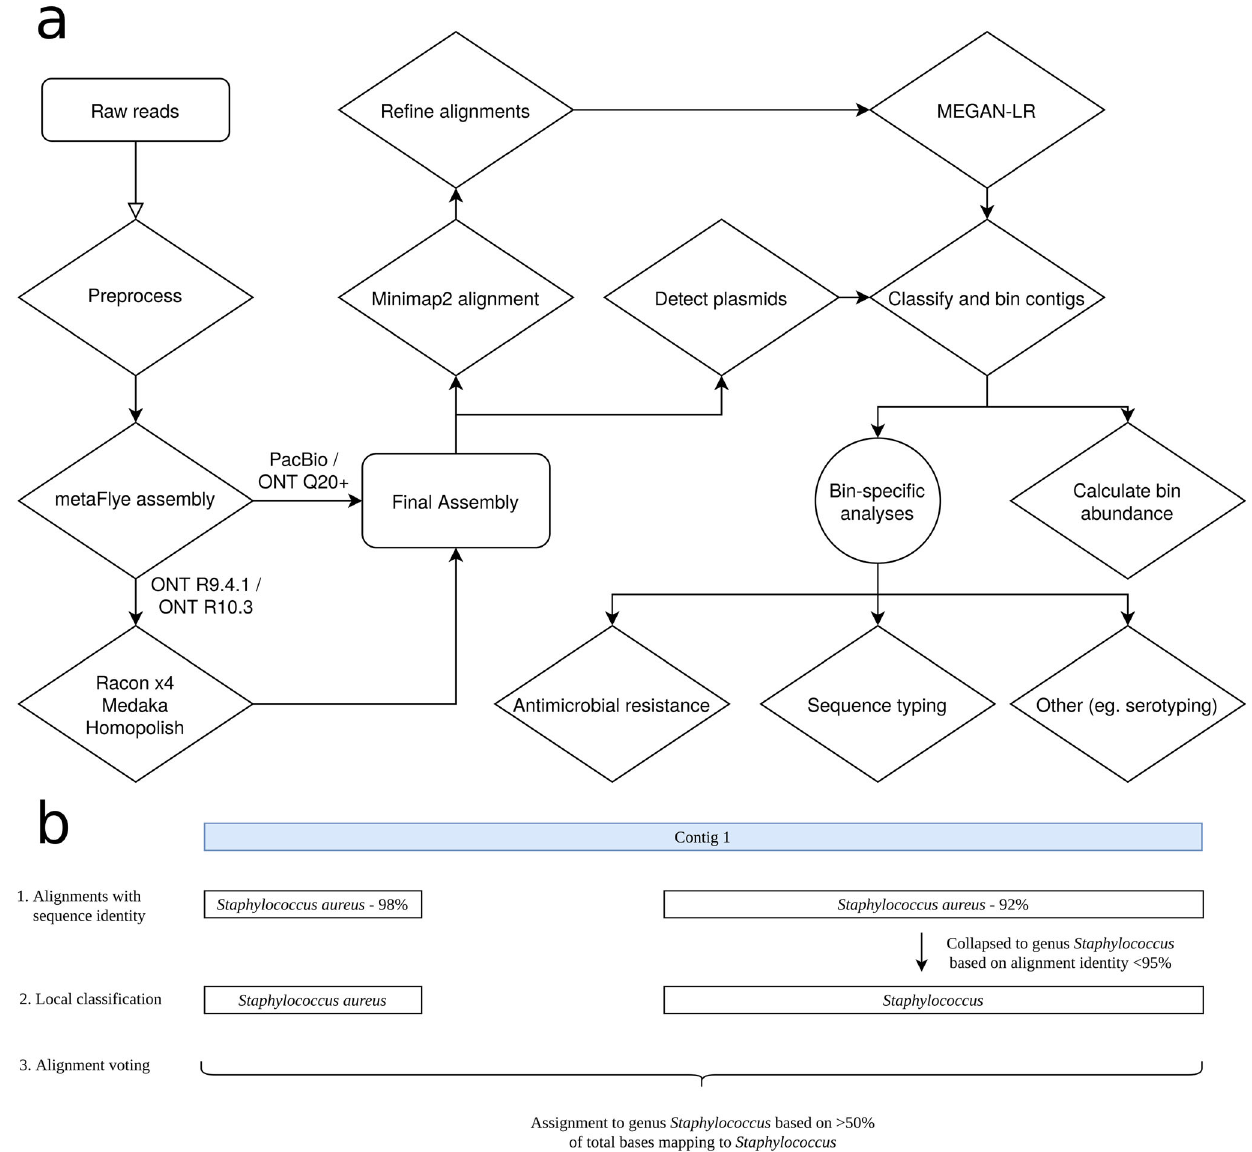
Fig. 1 Overview of full BugSplit work fl ow and example of contig classi fi cation algorithm. a Flow of data through the BugSplit work fl ow. Rectangles represent data points, diamonds represent processes, and circles represent forks in analysis. b Example application of contig classi fi cation algorithm. Alignments against the reference database are fi rst collapsed up the taxonomic tree based on absolute nucleotide identity. A base-level vote is then performed across all bases of a contig, determining the fi nal taxonomic assignment of the contig based on rank-speci fi c majority